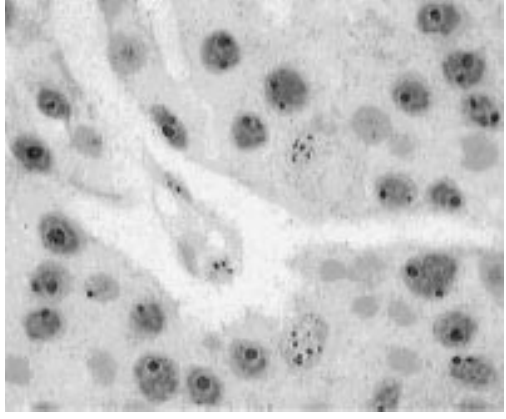
Fig. 1. Cells of invasive ductal breast cancer (G2). Dual staining for ER and AgNORs (objective 40 (cid:2) ). positive as well as in ER-negative nuclei, AgNORs are visible as black-brownish dot-like structures (Fig.